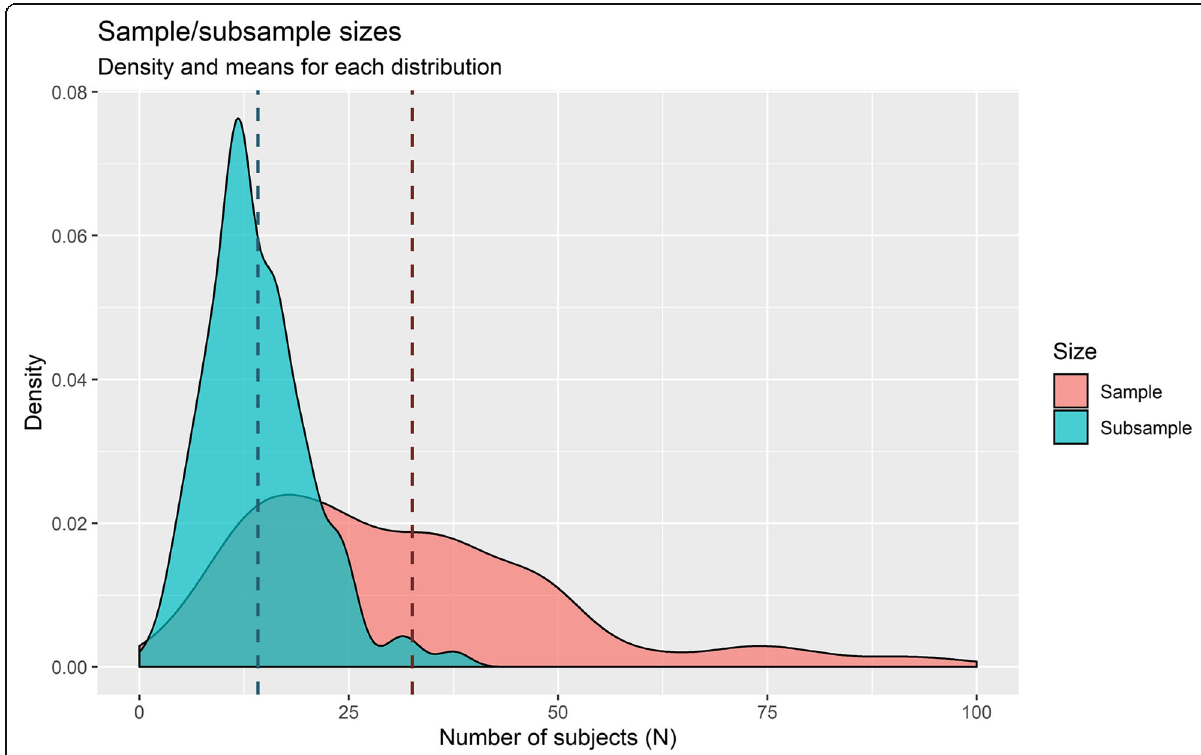
Fig. 4 Sample/subsample sizes. Densities and means for each